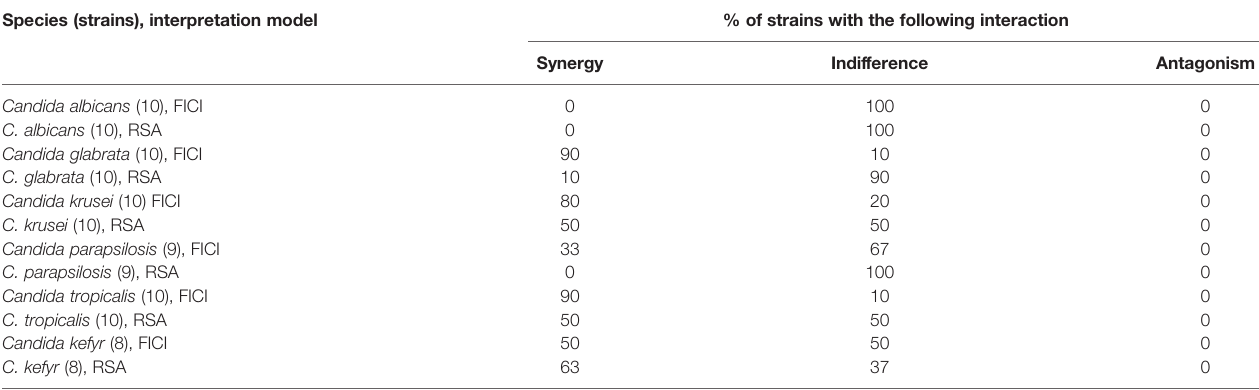
FICI, fractional inhibitory concentration index; RSA, response surface analysis; EUCAST, European Committee on Antimicrobial Susceptibility Testing.